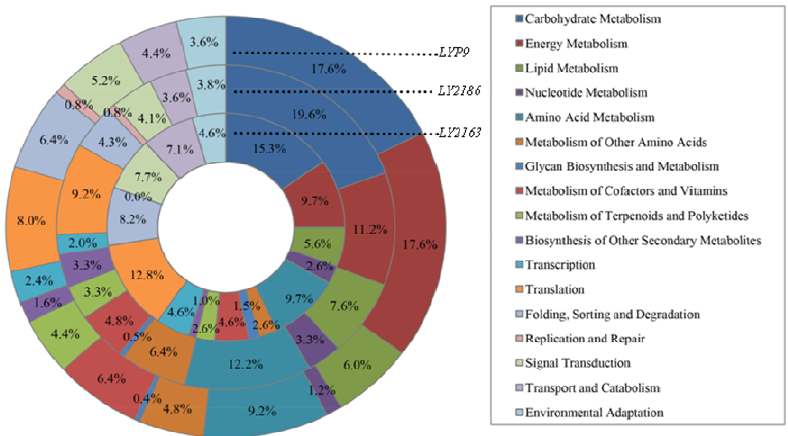
Figure 4. Graphical representation for the function classification of DGs in the F of three hybrid